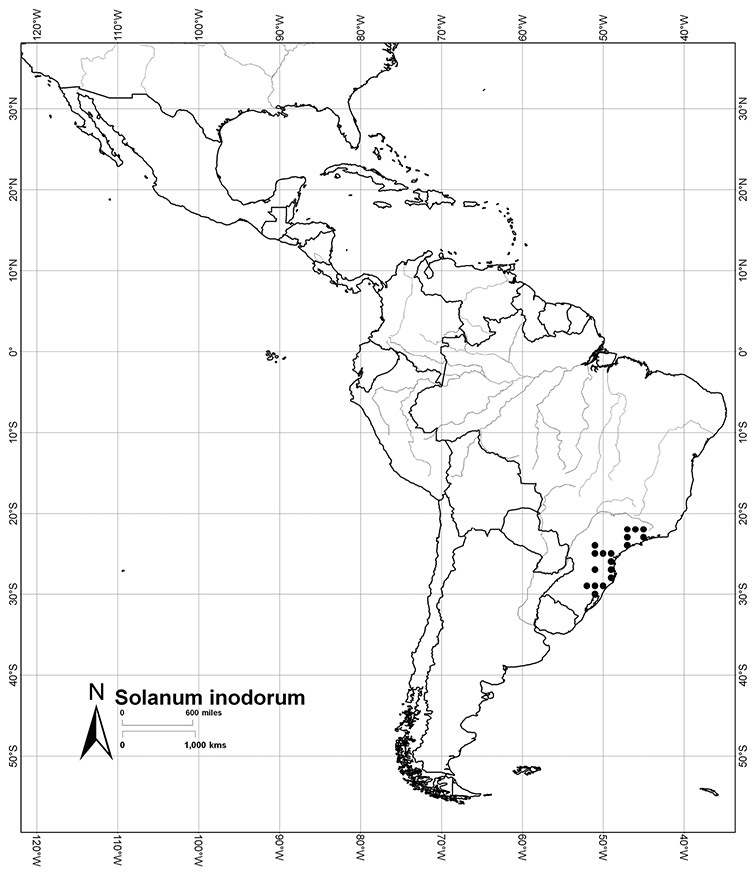
Distribution of Solanum inodorum Vell.